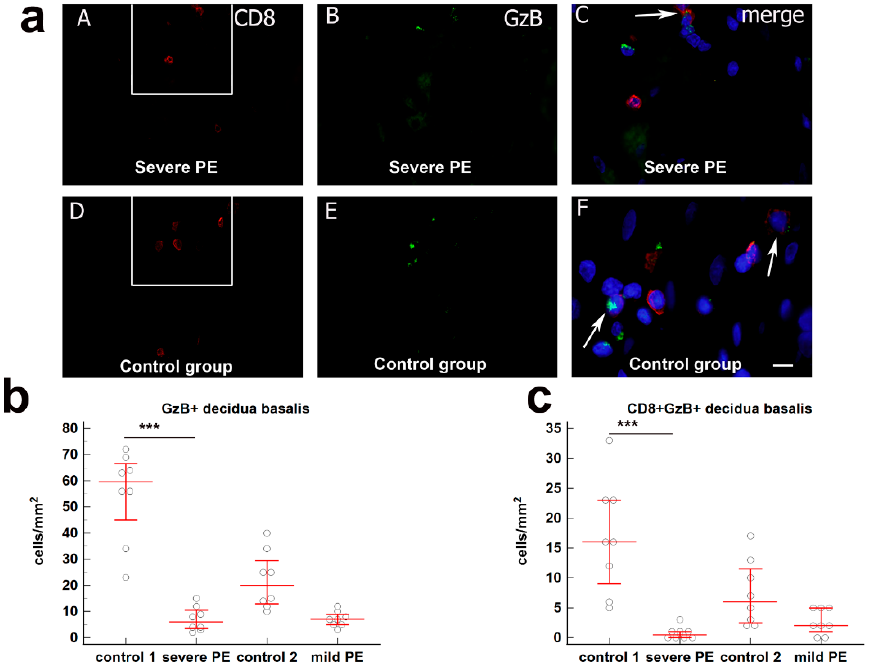
Figure 2. ( a ) ( A – C ) Co-expression of CD8 and GzB markers in decdua basalis cells of the third trimester pregnancies in severe PE. Double immunofluorescence staining showed CD8 ( A ) and GzB ( B ) positive cells. Merging ( A ) and ( B ) revealed co-expression of CD8 and GzB (arrow) ( C ). Scale bar = 10 µ m. ( D – F ) Co-expression of CD8 and GzB markers in decdua basalis cells of the third trimester pregnancies in control group. Double immunofluorescence staining showed CD8 ( D ) and GzB ( E ) positive cells. Merging ( D ) and ( E ) revealed co ‐ expression of CD8 and GzB (arrows) ( F ). Scale bar = 10 μ m. Magnification frame on ( A ) and ( D ) is shown on ( C ) and ( F ), respectively; magnification on ( A , B , D , E ) is ×40; magnification on ( C ) and ( F ) is ×80. Expression of ( b ) GzB+ and ( c ) CD8+GzB+ in decidua basalis in severe PE ( n = 8), mild PE ( n = 8) and healthy age ‐ matched control 1 ( n = 8) and control 2 ( n = 8). Data were presented as the median ± IqR (vertical line). Significant differences were indicated by p *** < 0.0001 (Kruskal–Wallis test and Dunn’s multiple comparison test).